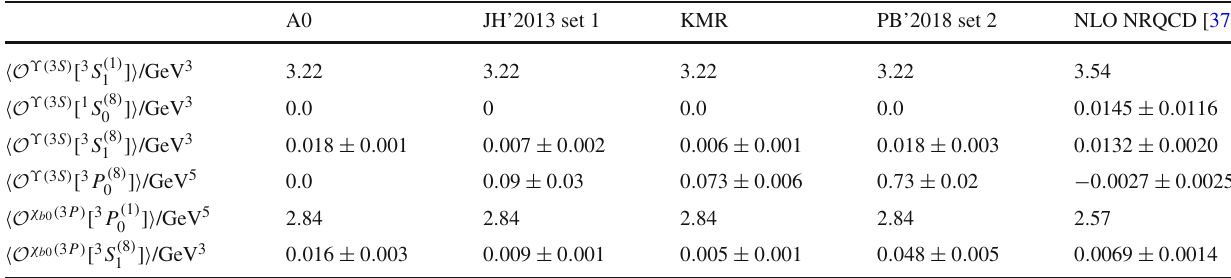
Table 1 The NMEs for ϒ( 3 S ) and χ b ( 3 P ) mesons as determined from our fit at p cut are shown for comparison